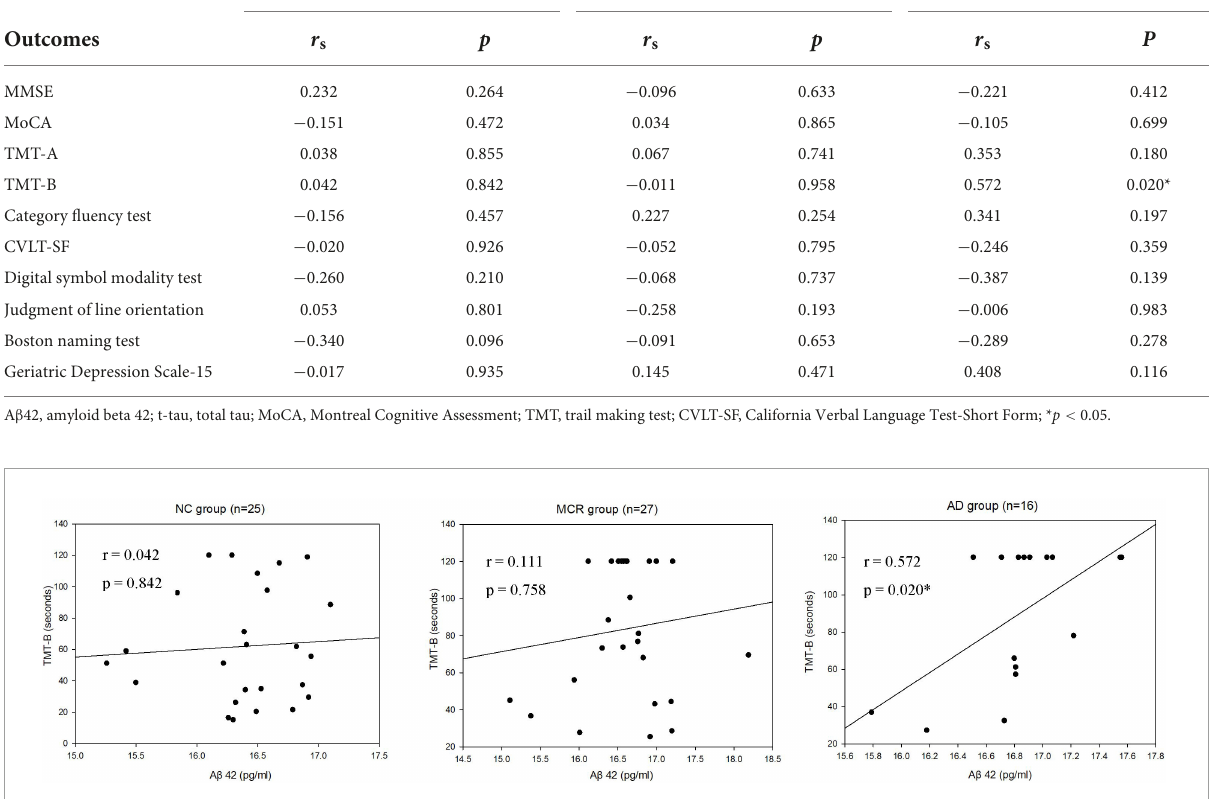
FIGURE1 Scatterplots of the associations between TMT-B and plasma A β 42 levels (pg/ml) in the three groups. NC, normal cognition; MCR, Motoric Cognitive Risk syndrome; AD, Alzheimer’s disease; A β 42, amyloid beta 42; TMT-B, trail making test-part B; * p <